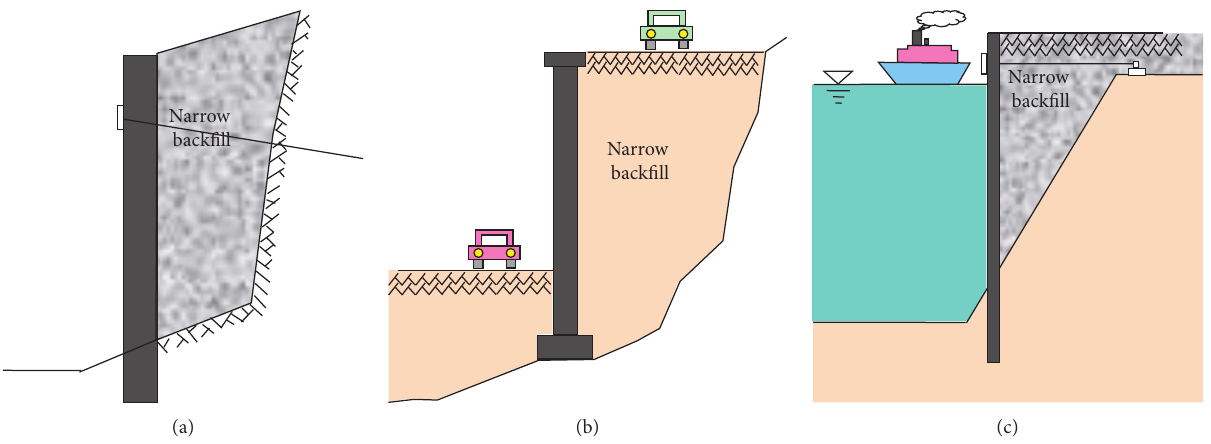
Figure 1: Narrow backfill in engineering. (a) Slope protection. (b) Mountain highway. (c) Sheet-pile